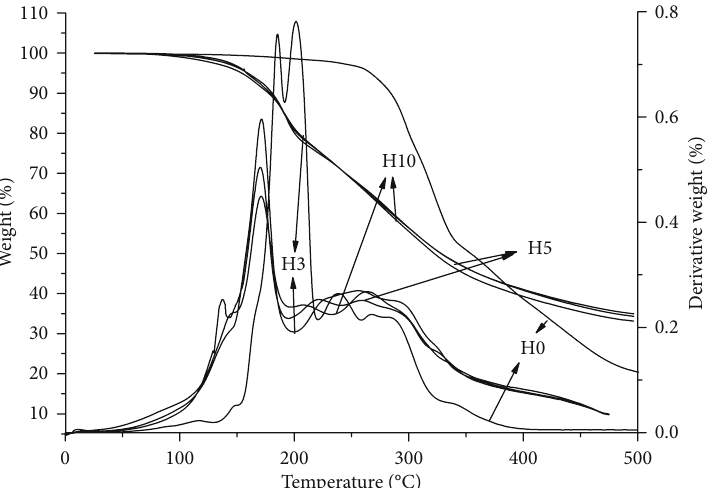
Figure 11: TGA thermogram of hydrogel samples with di ff erent concentrations of CA (H3, H5 and H10) and the non-cross-linked hydrogel